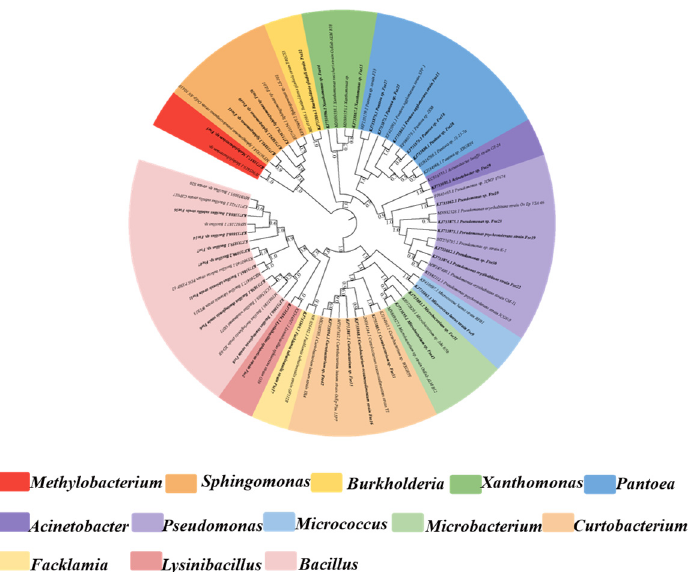
Figure 2. Phylogenetic tree of representative strains of each species of endophytic bacteria in DXWR and relative strains in GenBank database based on 16S rDNA sequences.